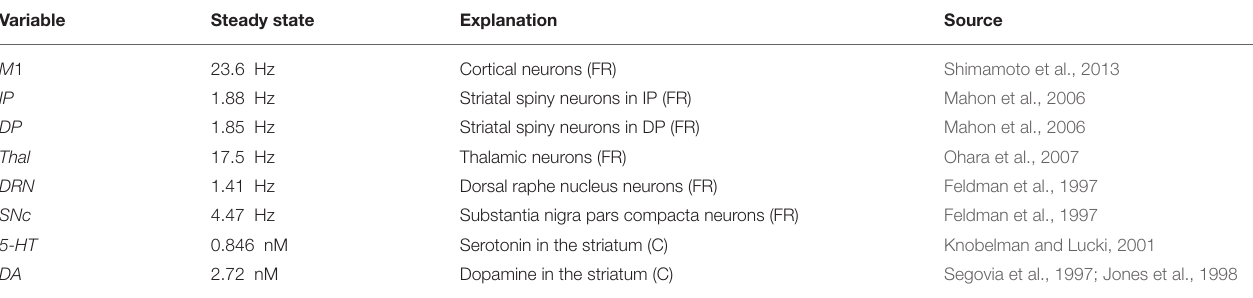
TABLE 2 | Variables of the equations.